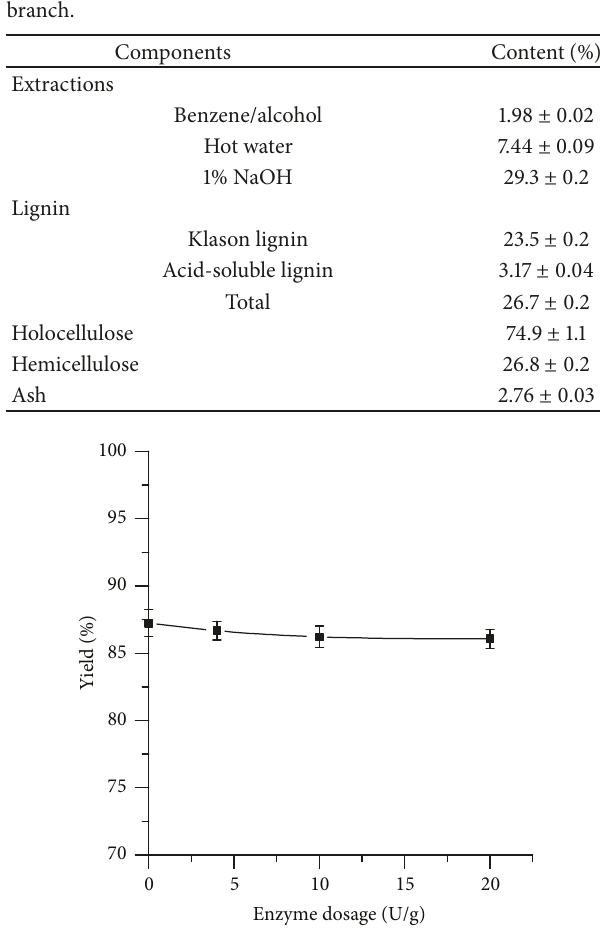
Figure 2: Effect of xylanase pretreatment on the yield of refiner mechanical